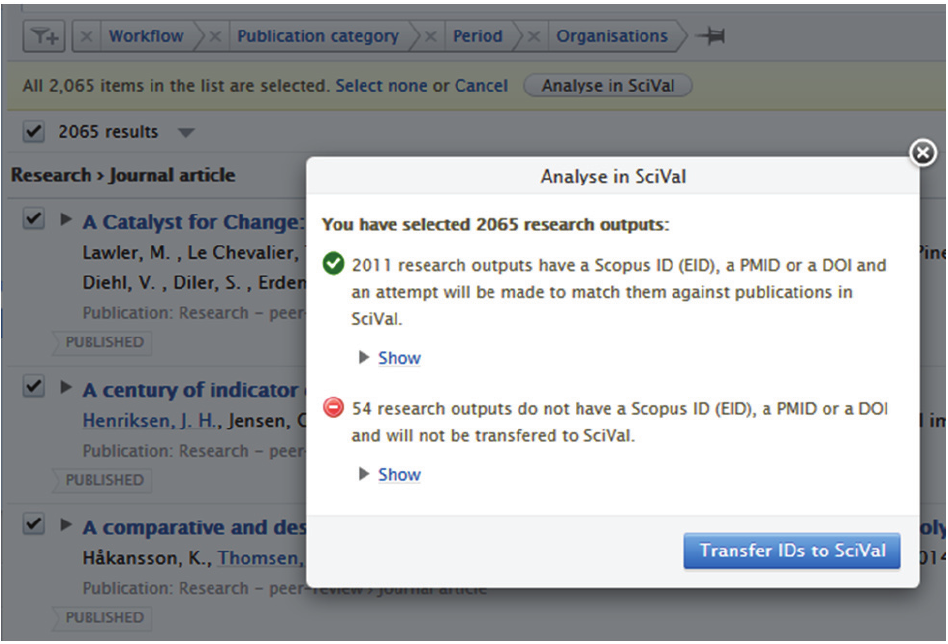
Figure 1. Screenshot from Pure. Publication set automatically analyzed for UIDs before export to SciVal, August 2015. Source: Pure from Elsevier, version 4.23.1, local installation at University of